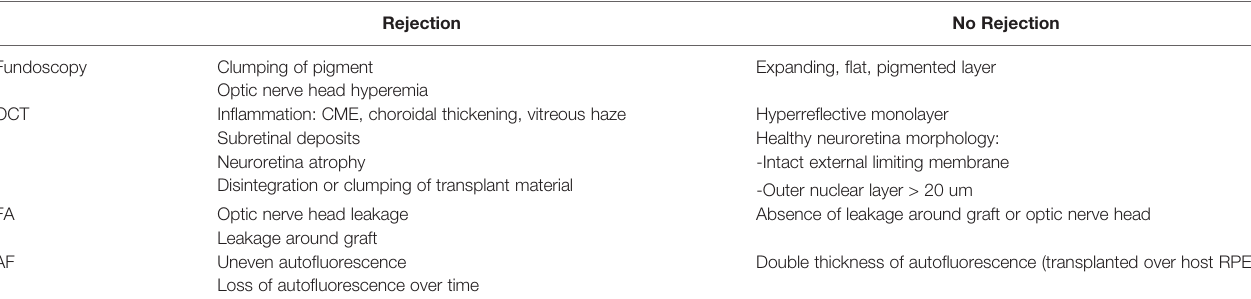
TABLE 1 | Comparison of visual signs of rejected versus non-rejected transplanted RPE.